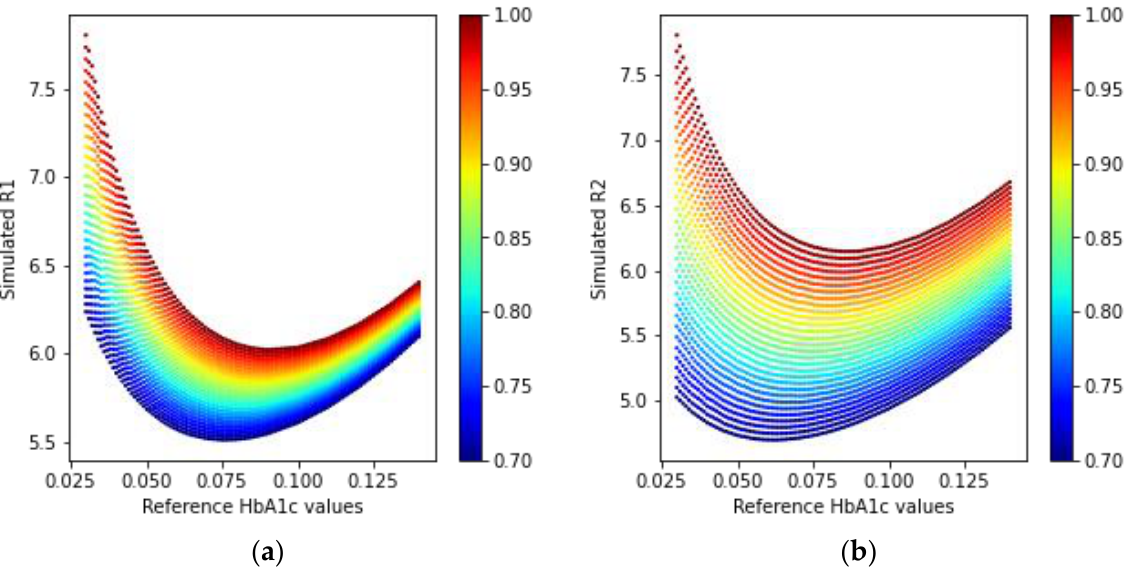
Figure 11. Simulated ratio values ( a ) R1 and ( b ) R2 from the received intensities in the transmission mode PD.